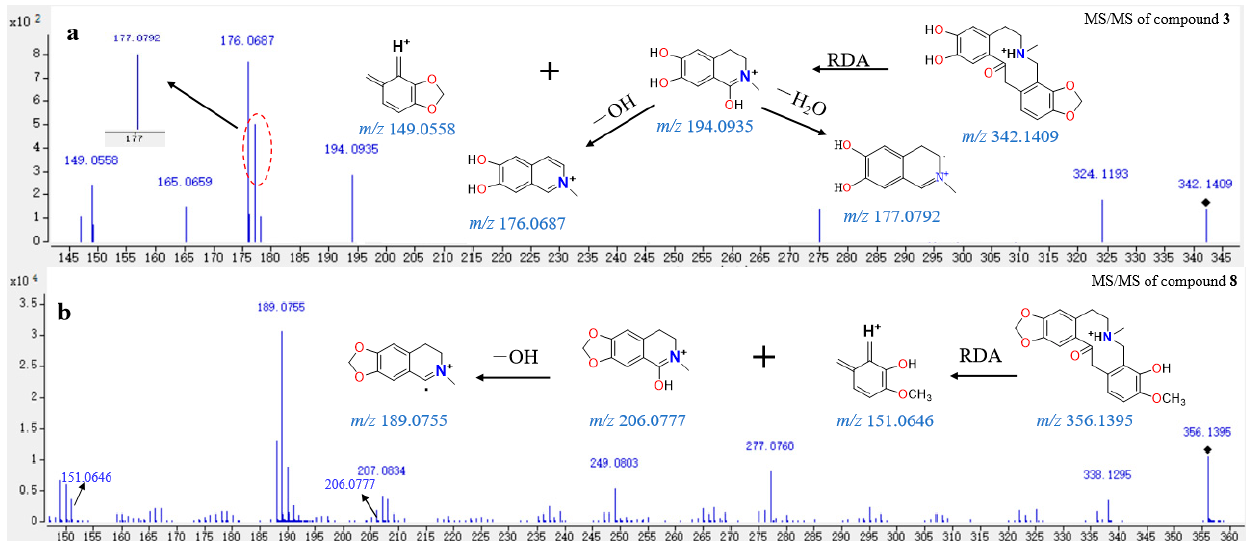
Figure 5. MS/MS spectra of compounds 3 ( a ) and 8 ( b ) and corresponding fragmentation